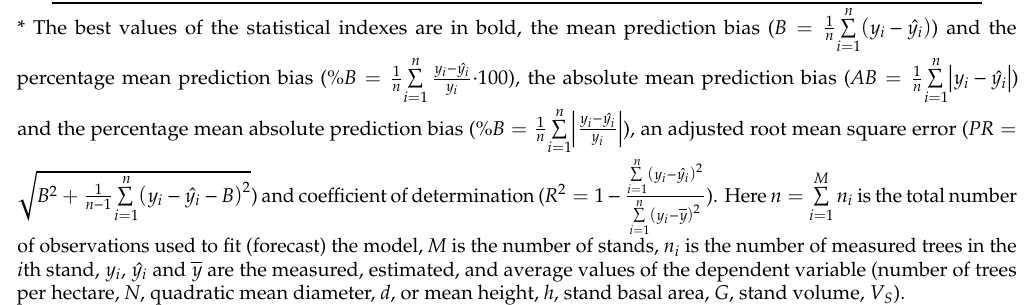
* The best values of the statistical indexes are in bold, the mean prediction bias ( B = 1